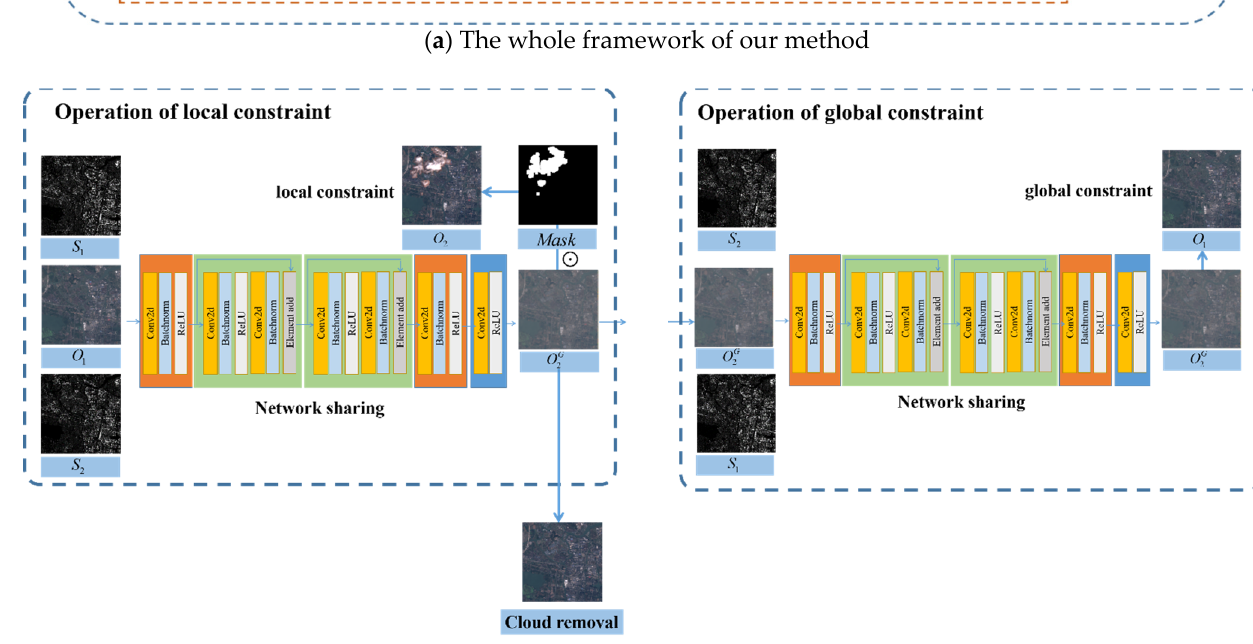
Figure 1. The flowchart of our